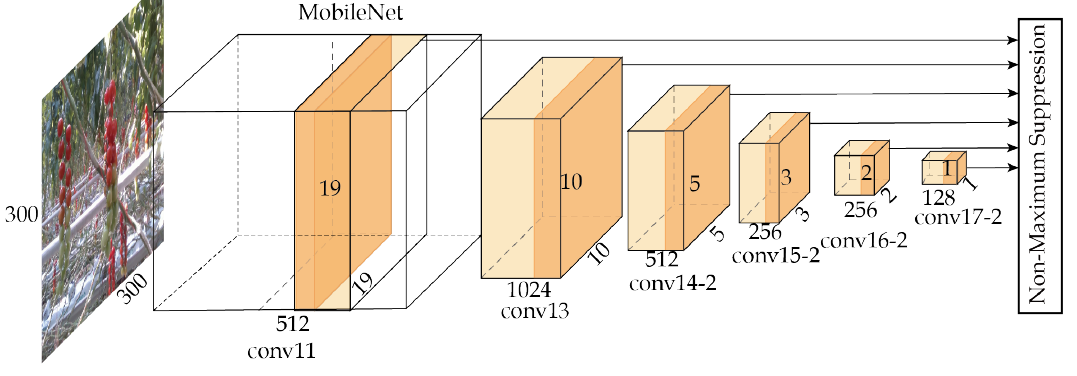
Figure 4. Architecture of improved SSD deep learning